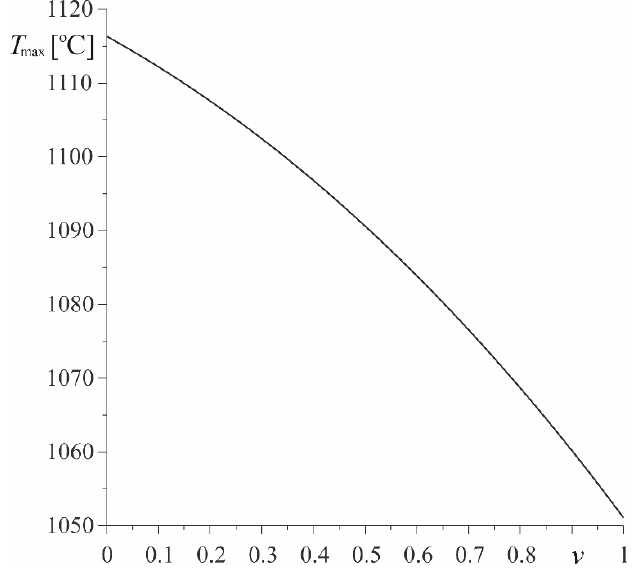
Figure 10. Dependency of maximum temperature T max during braking with constant deceleration on the volumetric fraction v .